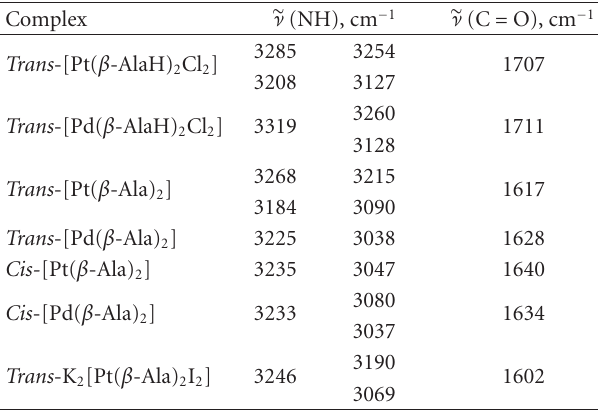
Table 2: IR spectral data for the Pt(II) & Pd(II) complexes with β